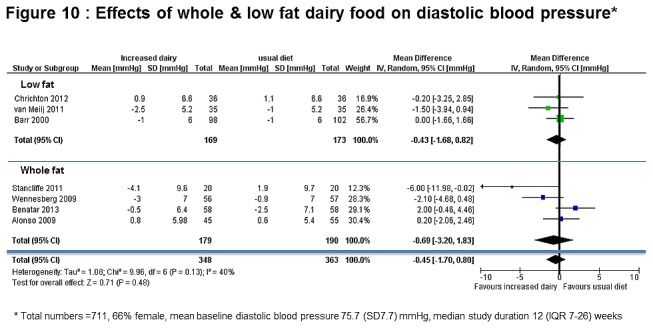
Effects of whole & low fat dairy food on diastolic blood pressure.